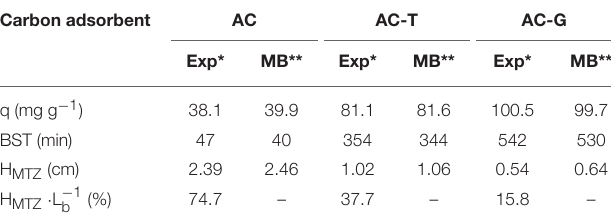
TABLE 5 | Breakthrough profile